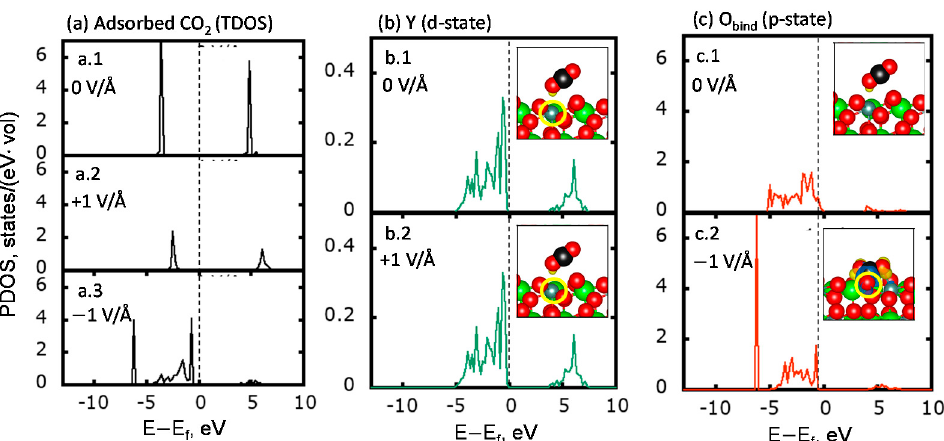
Figure 6. Electronic structure analysis regarding the adsorption of CO 2 on YSZ (111) in the presence and in the absence of an electric field. Density of states analyses comprised of ( a ) total density of states of an adsorbed CO 2 , ( b ) d -state PDOS of Y-cation circled in yellow on the subset, and ( c ) p -state PDOS of O bind circled in yellow on the subset. The black, red, dark-green, and light-green spheres are C, O, Y, and Zr, respectively.